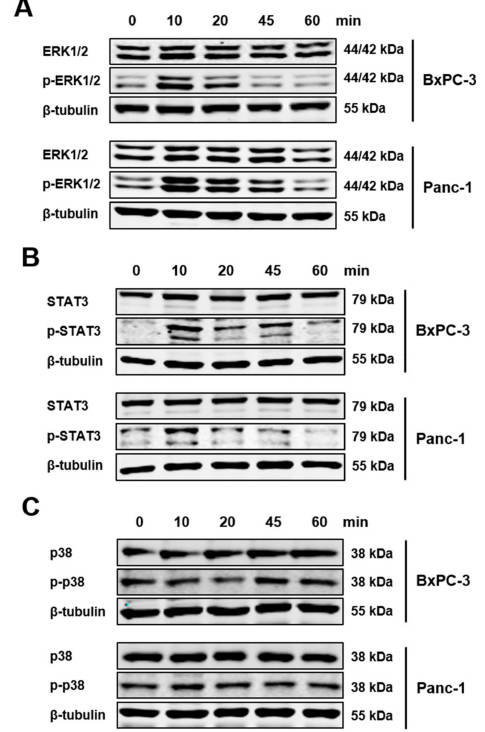
Figure 4. IL-21R activates ERK and STAT3 pathway; but not p38. PDAC cells BxPC-3 and Panc-1 were incubated with IL-21 (10 ng / mL) for the time indicated. Phosphorylation of ( A ) ERK, ( B ) STAT3, and ( C ) p38 was evaluated. β -tubulin was used as a loading control. After 10–20 minutes, phosphorylation of ERK and STAT3 could be detected. One of three independent experiments is